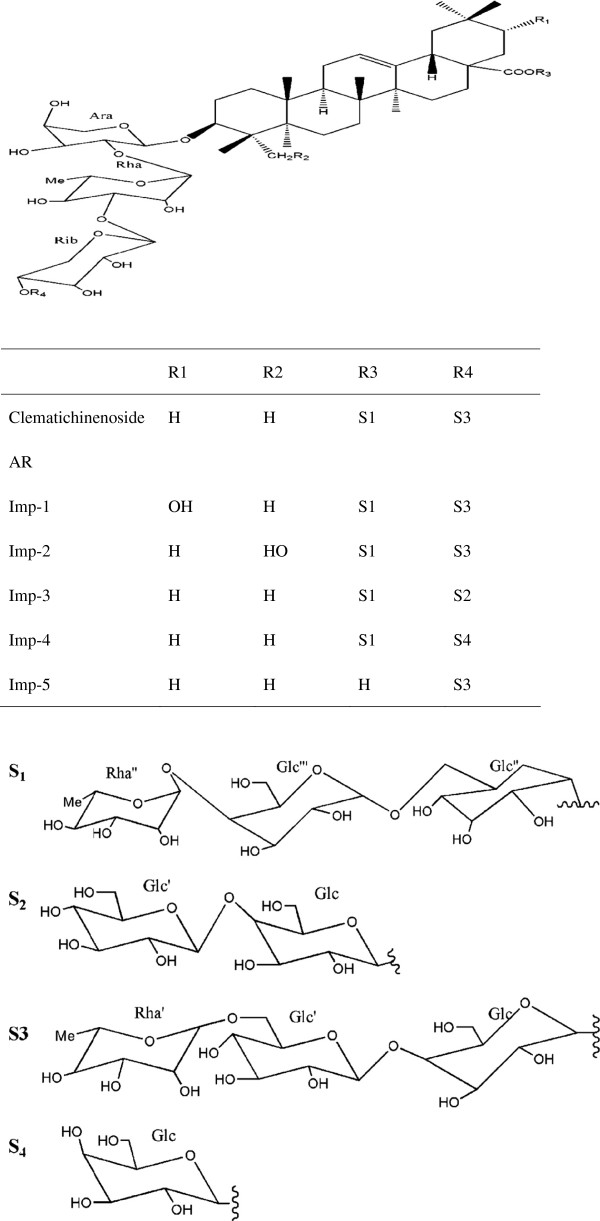
The chemical structures of Clematichinenoside AR and its related impurities.